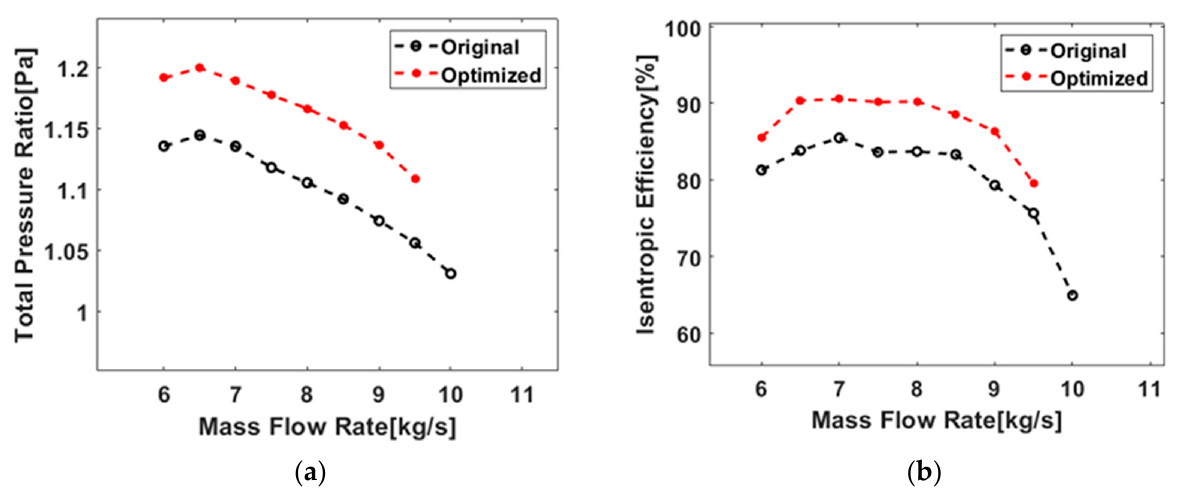
Figure 13. Overall performance curves of the original ( a ) and optimized ( b ) blades.